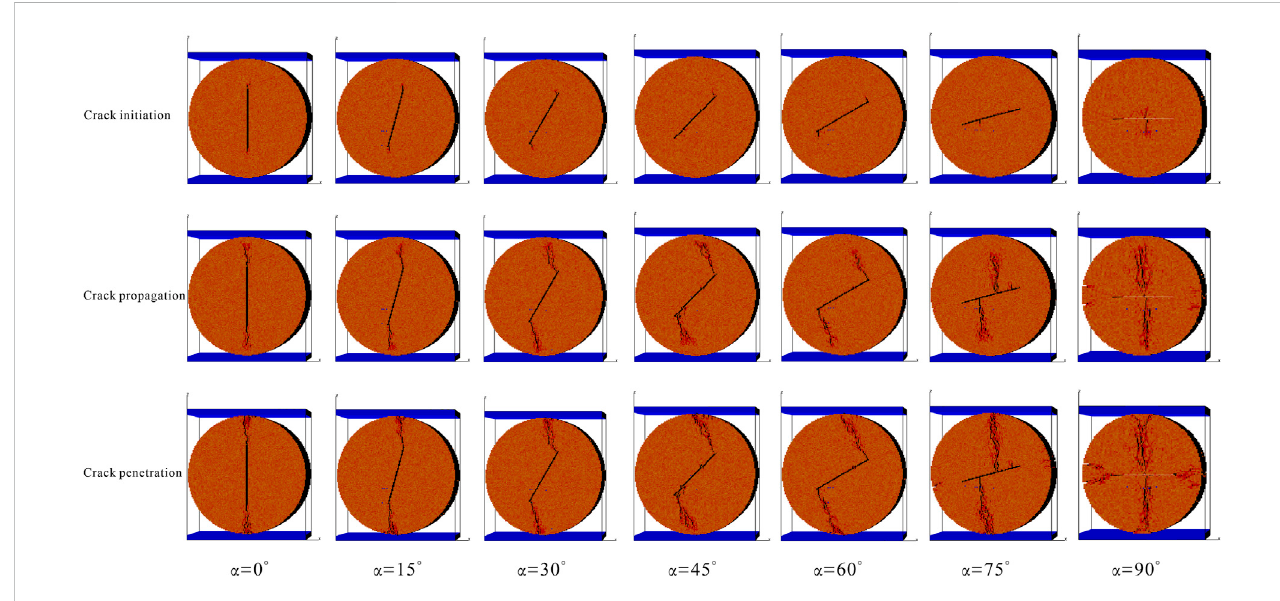
FIGURE 8 Crack extension pattern of numerical simulation